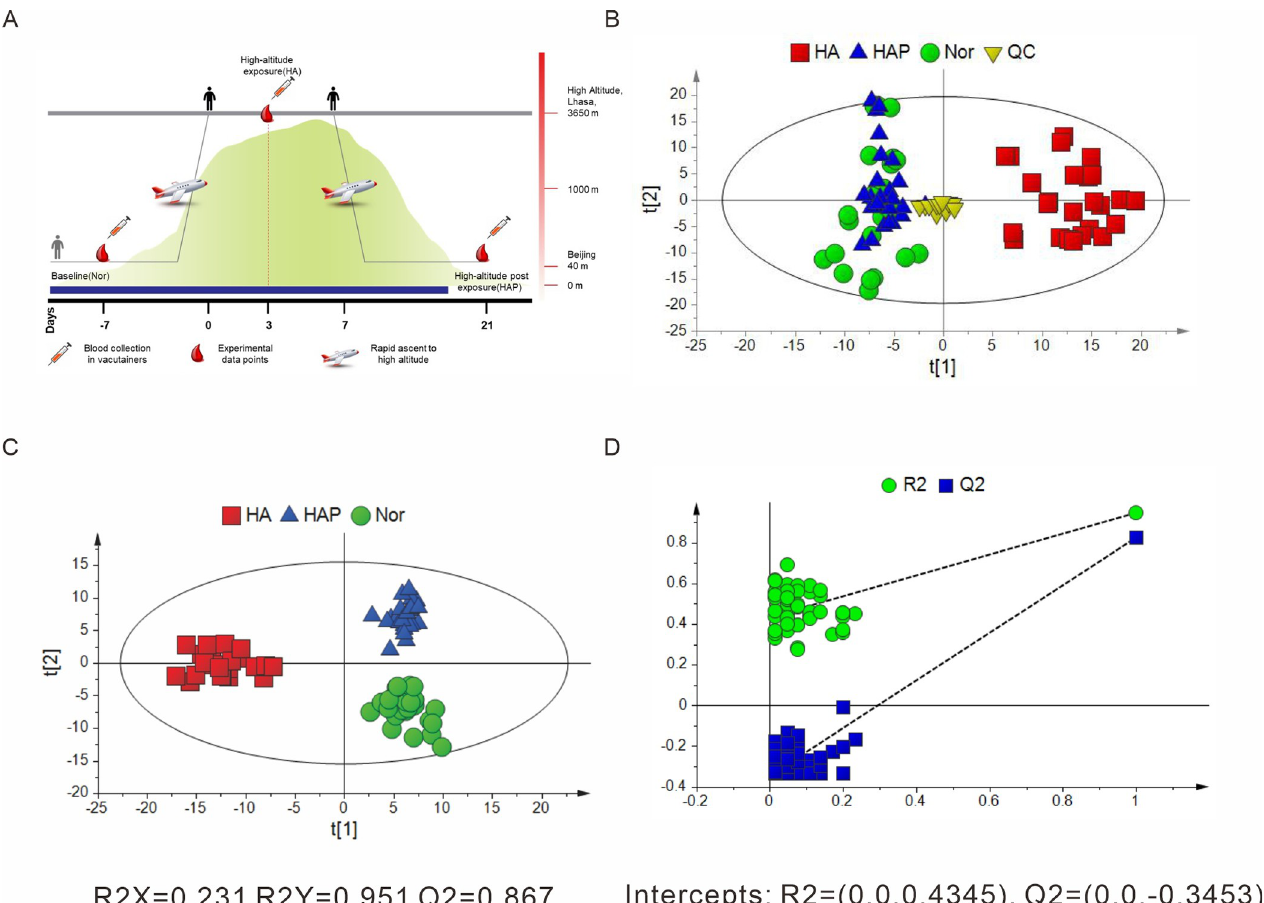
Fig 1. The metabolic profiles of plasma samples. Schematic diagram of sample taking (A). PCA (B) and PLS-DA (C) score plots for Nor, HA and HAP based on metabolomics data and plot of permutation tests (n = 50) of PLS-DA model for plasma profiles detected with LC-MS.